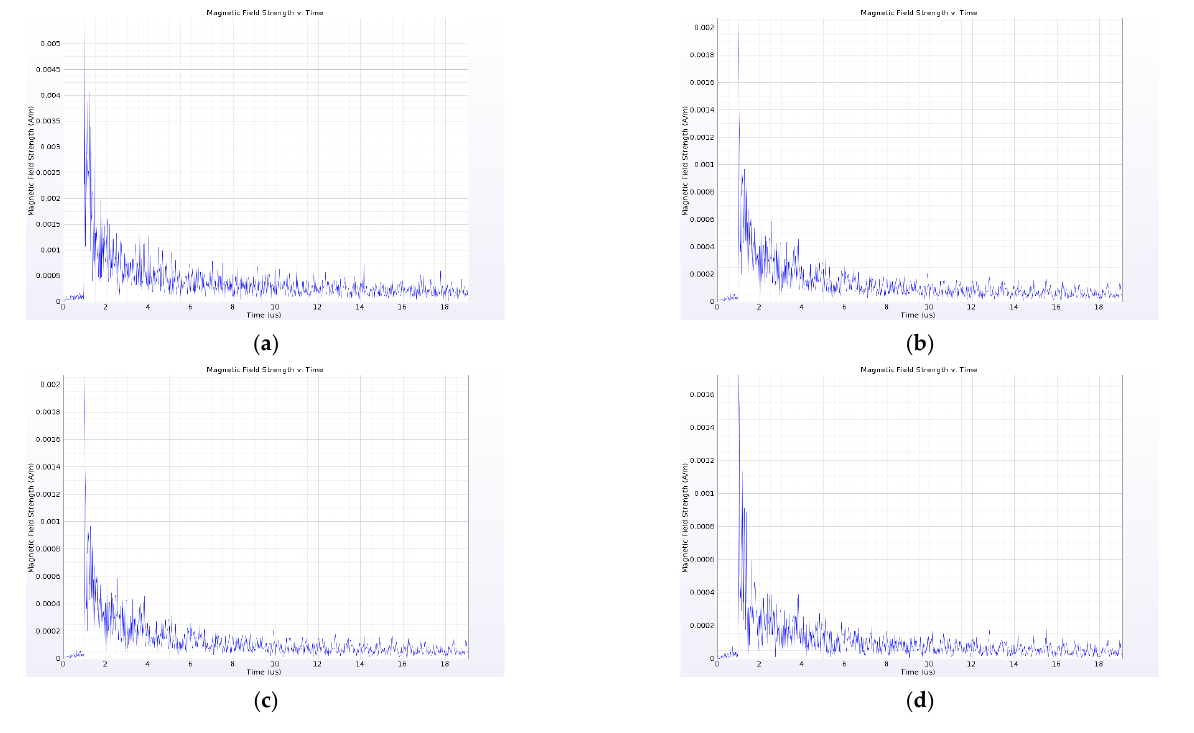
Figure 7. Effect of current transformer on near-field propagation characteristics of PD electromagnetic wave signal. ( a ) magnetic field strength at point sensor 1; ( b ) magnetic field strength at point sensor 2; ( c ) magnetic field strength at point sensor 3; ( d ) magnetic field strength at point sensor 4.